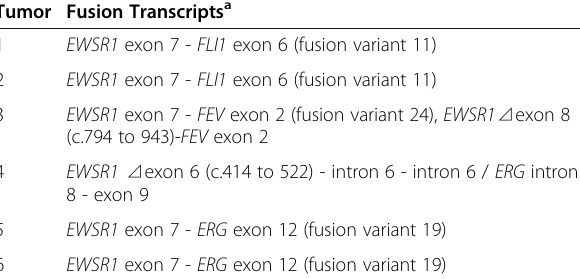
Table 2 Fusion transcripts identified in tumor samples Tumor Fusion Transcripts